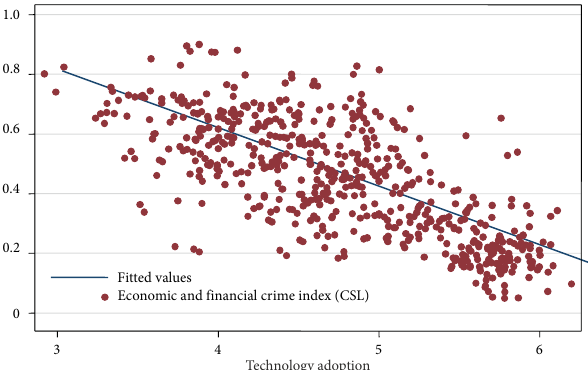
Figure 2. Plots of Economic and financial crime index (CSLindex) against technology expressed as Technology adoption